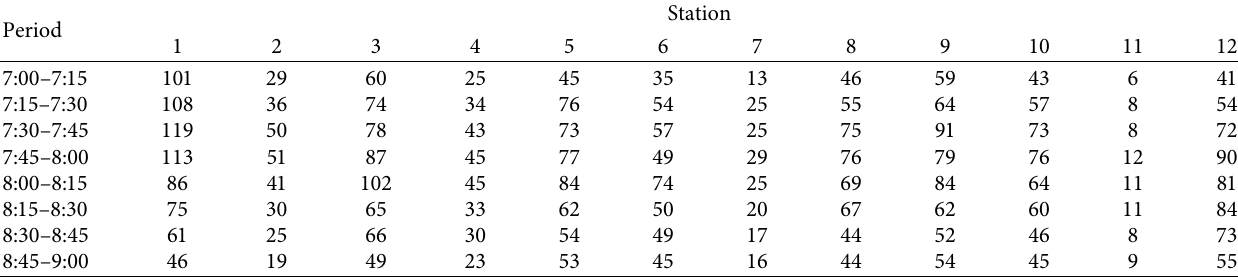
Table 14: The OD probability matrix for passengers on Batong line (unit: %).